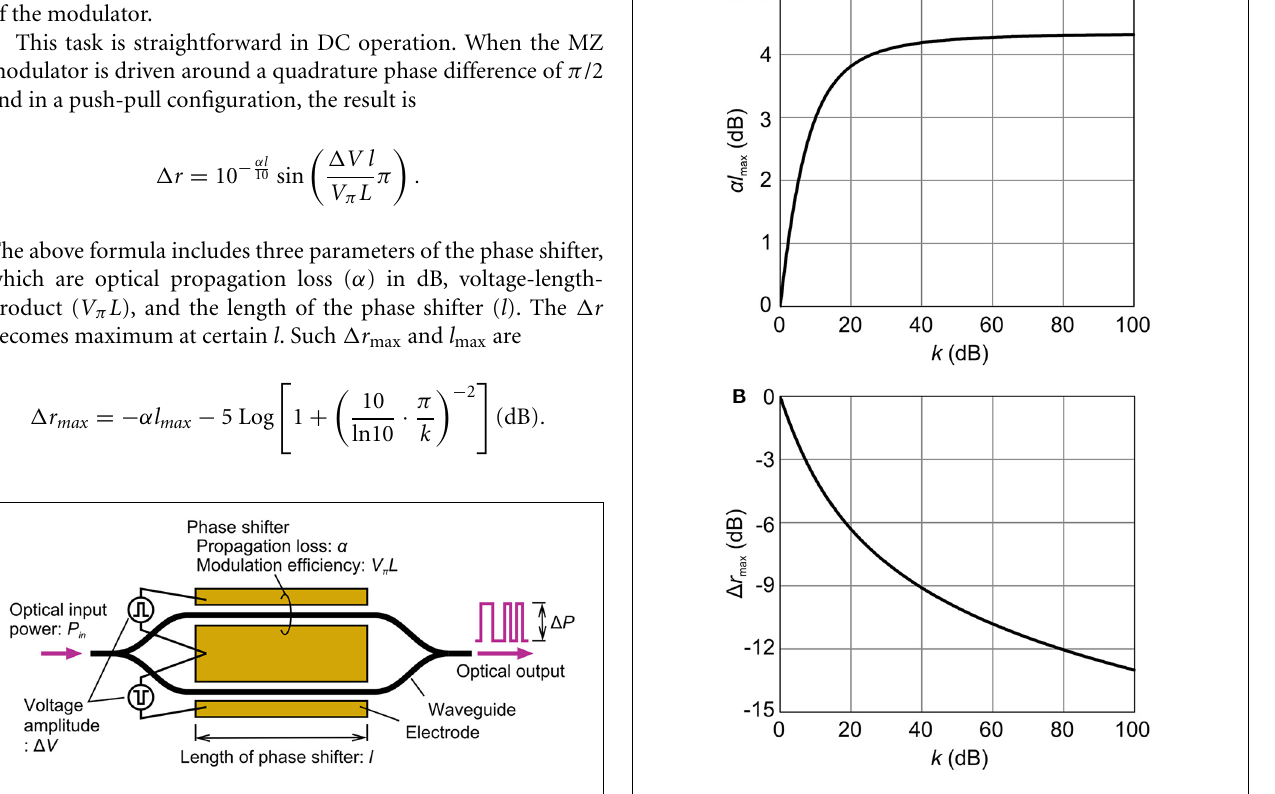
FIGURE 1 | Configuration of analyzed MZ modulator. Two phase shifters in MZ interferometer are driven with voltage amplitude of (cid:4) V in push-pull configuration.